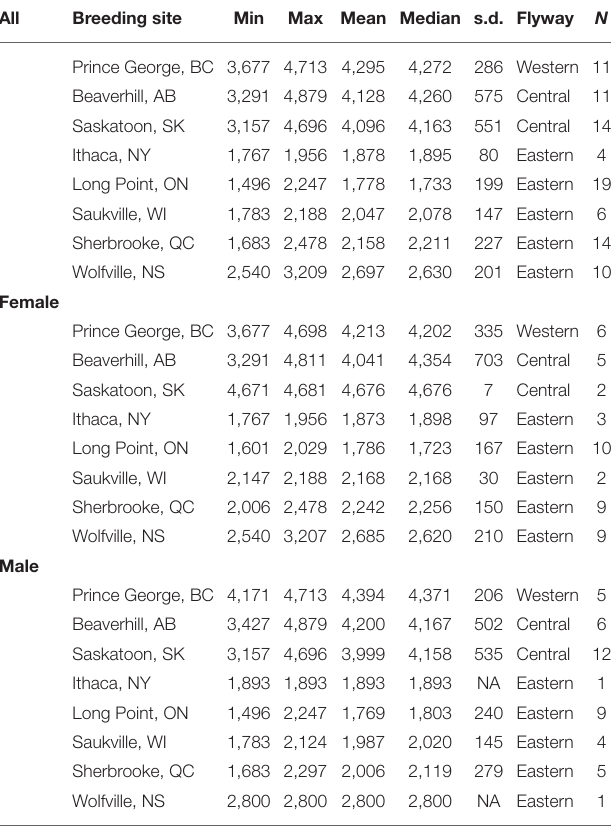
TABLE 1 | Summary of migration distances among breeding sites across sexes and separated by females and males. All Breeding